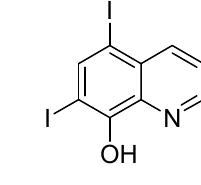
132 Figure 23. The most active antiamoebic 1,2,3-thiadiazoles 131 and 132. 3.5. Plant Activator Agents Plant activators are synthetic or natural chemicals entities that protect plants from different pathogens. Among them, pyrimidin-type plant activator 2 (PPA2 133 ; Figure 24) significantly enhanced plant defense system against bacterial infections unlikely tradi- tional commercially available plant activators (INA 134 , BABA 135 , BHT 7 ; Figure 24). Plant activators not only showed their therapeutic potential against wide variety of pathogens but also increased growth of plants, rate of photosynthesis and overall yield of crops [144–148].